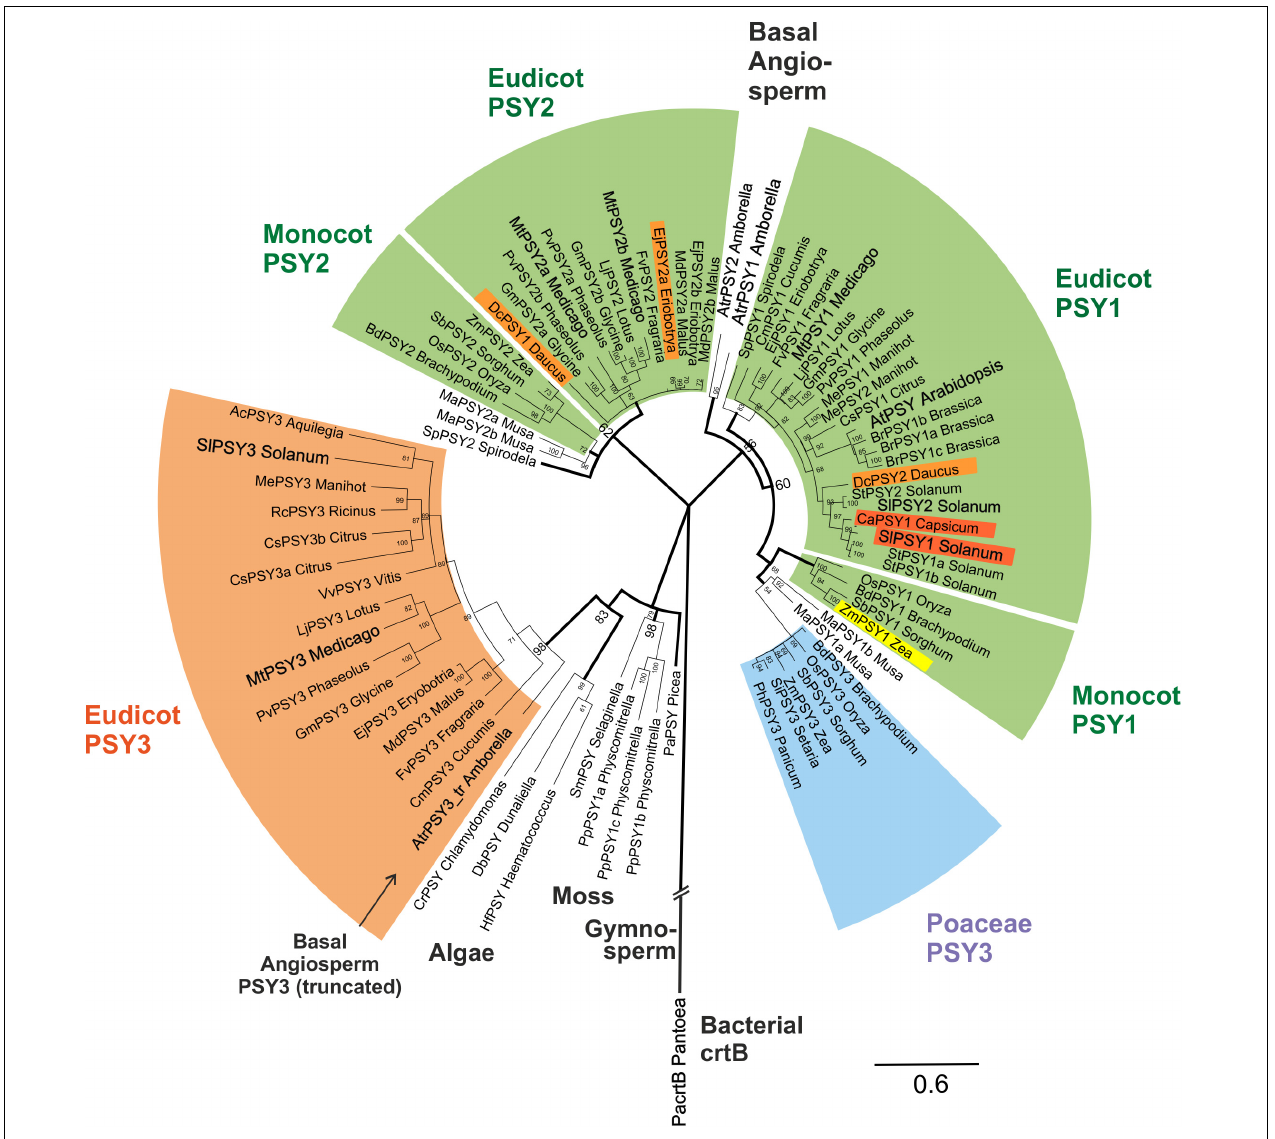
FIGURE 4 | Molecular phylogenetic analysis of PSY amino acid sequences. Eighty one PSY amino acid sequences from bacteria, algae, primitive plants, and higher plants were subjected to a Bayesian inference of phylogeny by the MrBayes plugin of the Geneious software package (Huelsenbeck and Ronquist, 2001). The phylogeny estimation is based on a CLUSTALW alignment shown in Supplementary Figure S4, which included a bacterial crtB sequence and a truncated sequence (192 aa) from the basal angiosperm A. trichopoda (AtrPSY3_tr Amborella, marked by arrow). Various clades of angiosperm PSYs are marked by colors and single PSYs investigated in this work are enlarged and in bold text. The newly defined eudicot PSY3 branch (orange clade) is most closely related to PSYs from algae, mosses and a gymnosperm. It clearly separates from the PSY3 of Poaceae (blue clade). Two separate angiosperm clades are assigned mainly to housekeeping photosynthetic functions (green clades, PSY1, PSY2), which also contain variants specifically expressed in single carotenoid-rich organs (colored PSYs within green clades). Posterior probabilities for nodes are given next to the nodes. Accession numbers or gene identifiers are listed in Supplementary Table